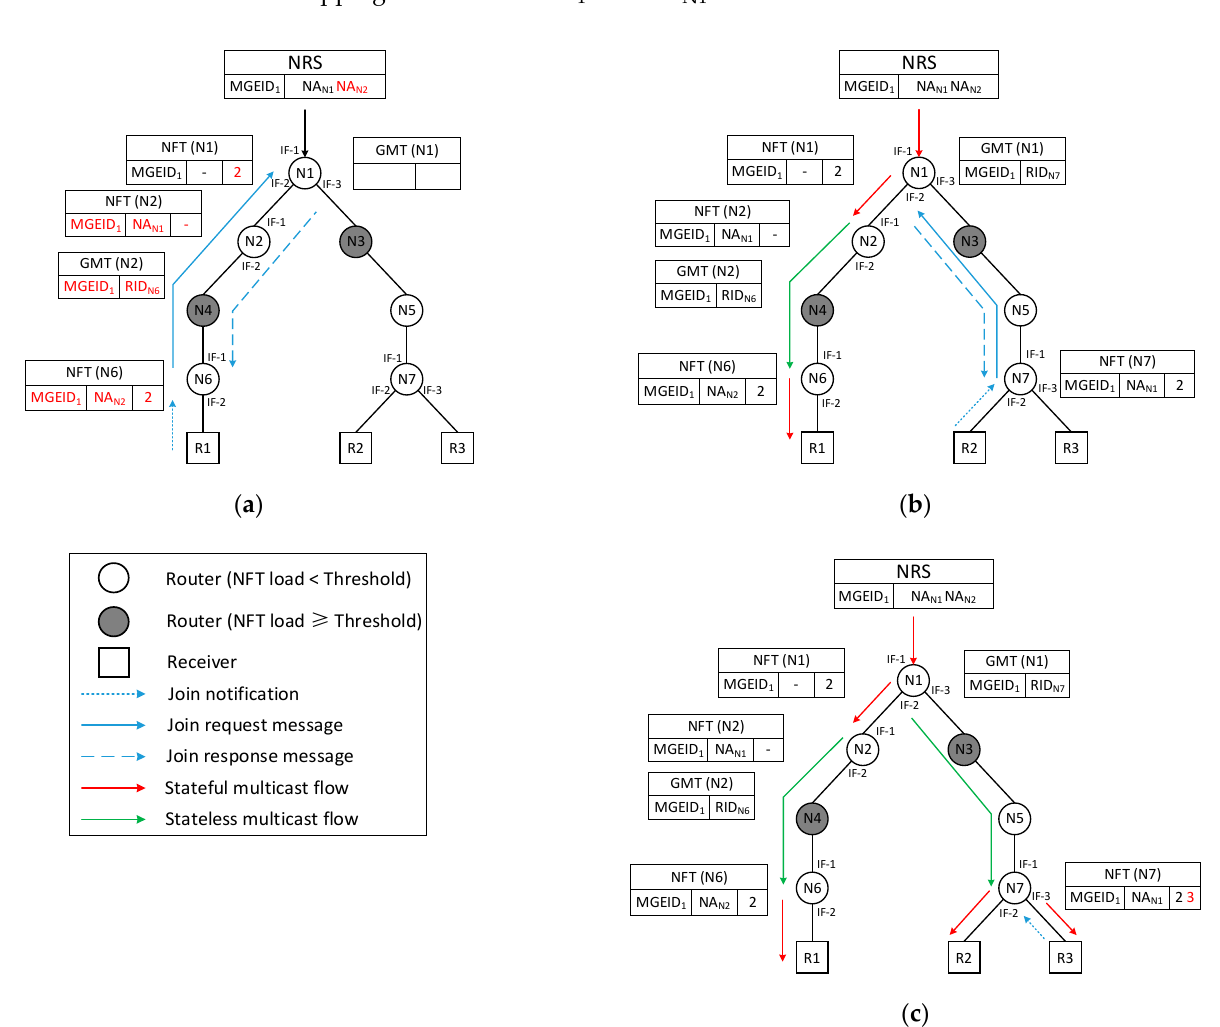
Figure 3. The example of the join process in AHHM. ( a ) R1 joins the multicast group; ( b ) R2 joins the multicast group; ( c ) R3 joins the multicast group.